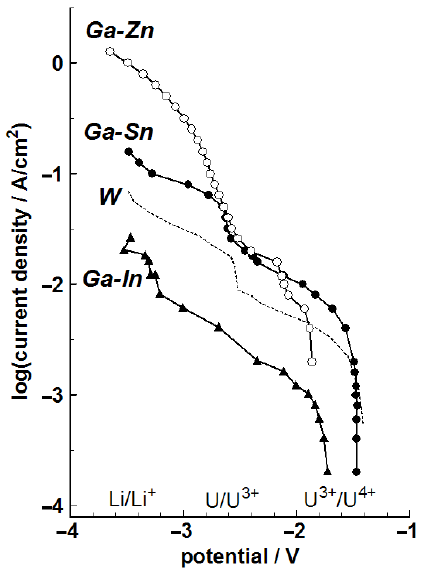
Figure 7. Polarization of liquid Ga–Zn, Ga–Sn and Ga–In cathodes in 3LiCl–2KCl based melts containing uranium chloride at 541 °C (2.08 wt. % UCl 3 ); 596 °C (0.90 wt. % UCl 3 ) and 550 °C (0.90 wt. % UCl 3 ), respectively. Potentials vs. 2Cl – /Cl 2 reference couple. Polarization curve for solid tungsten cathode is shown for comparison.